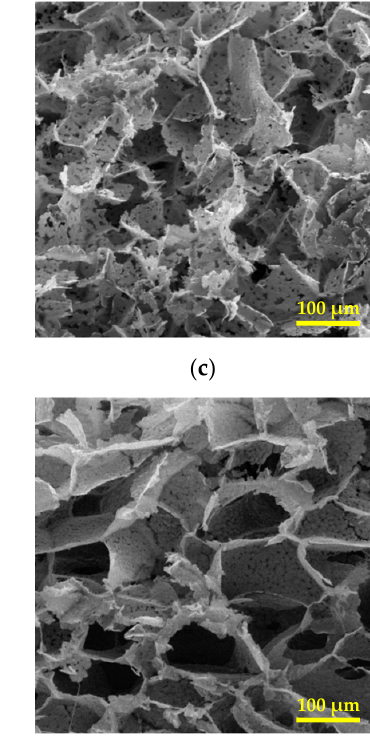
Figure 3. Scanning electron micrographs of cross-sections of PHBV scaffolds: ( a ) HBV5-R2, ( b ) HBV5-R6, ( c ) HBV12-R2, and ( d ) HBV12-R6.